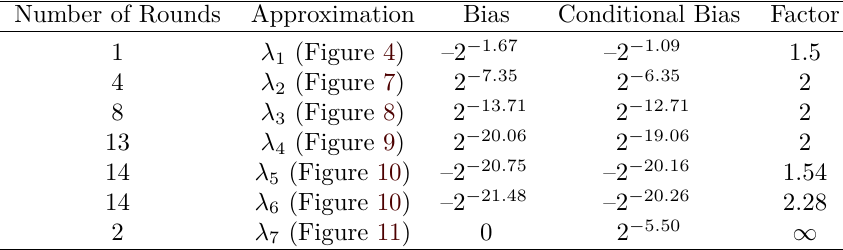
Table 4: Comparisons Between the Bias of Linear Approximations and Conditional Linear